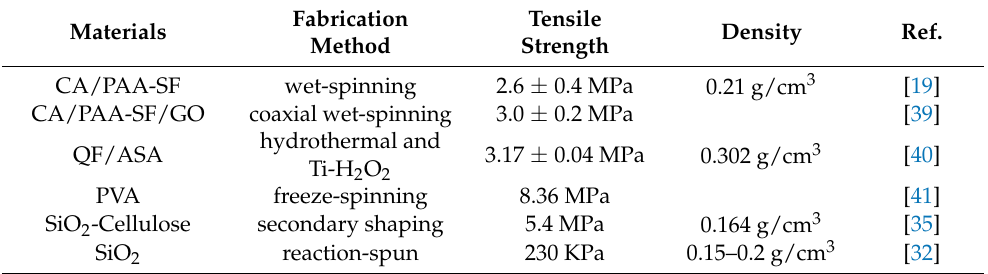
Table 2. Compositions, fabrication methods, tensile strength, and densities of the relevant aerogel fibers.